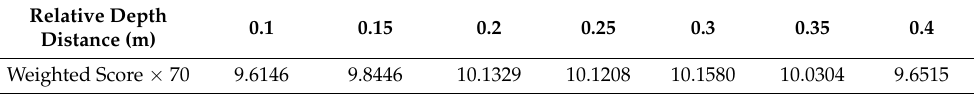
Table 23. Weighted total score of the depth distance for different relative